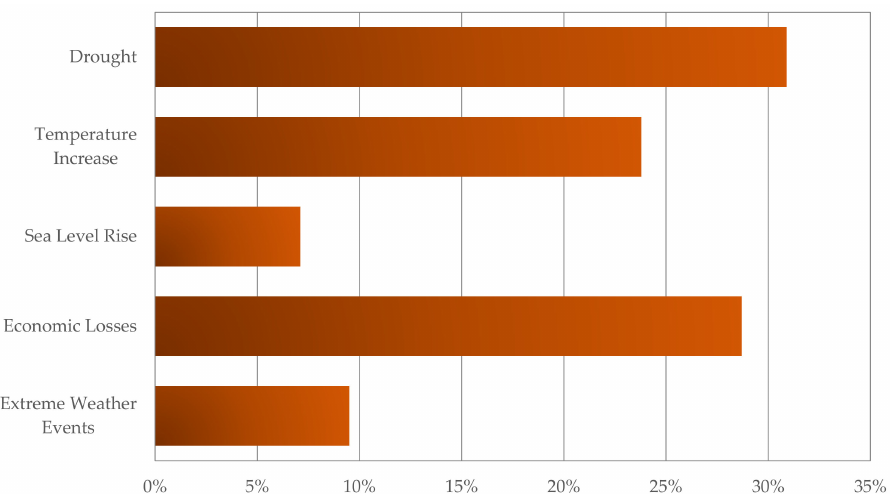
Figure 3. Respondents’ Perceptions: the three worst threats of climate change to tourism activity in Mykonos (Q5).